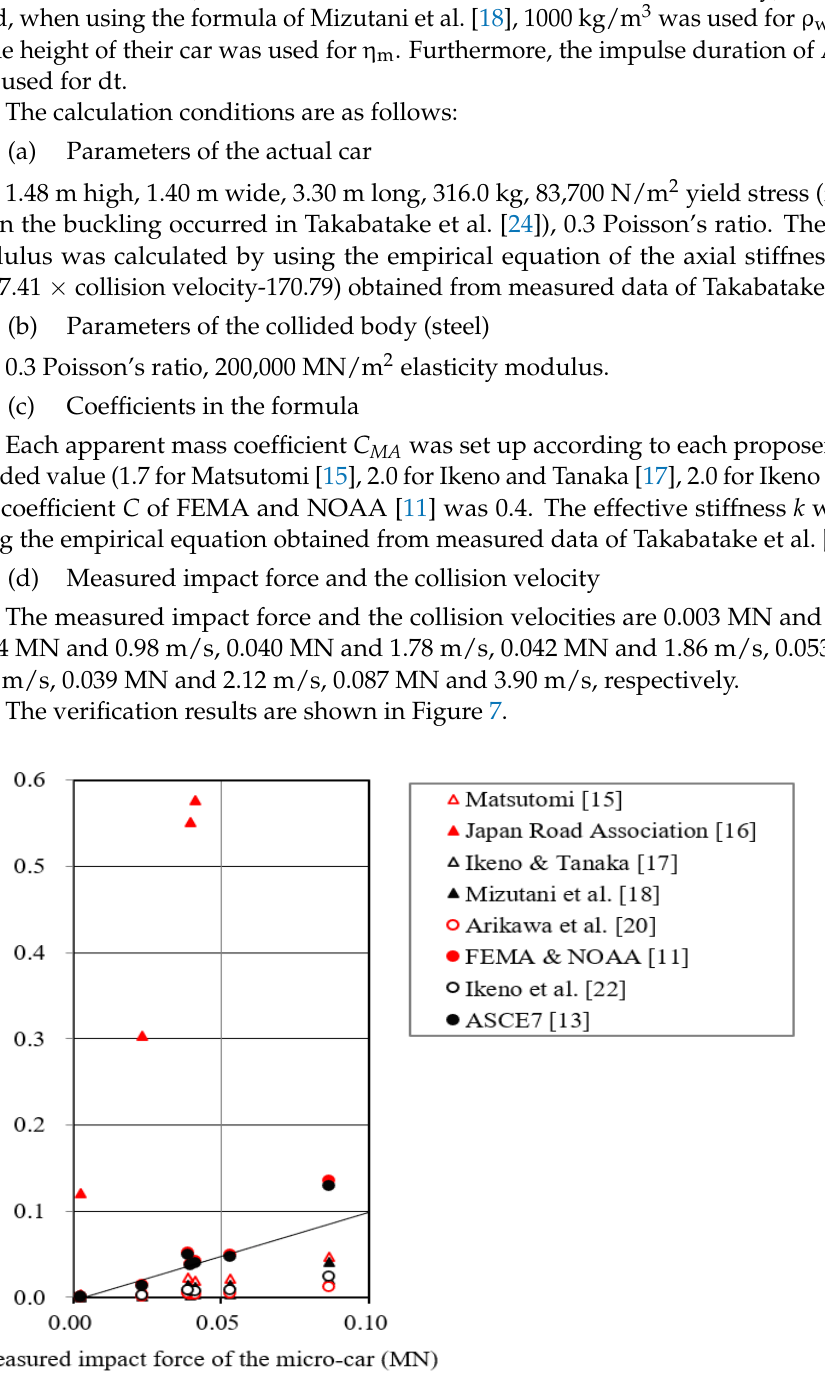
Figure 7. Comparison of impact forces for the microcar.